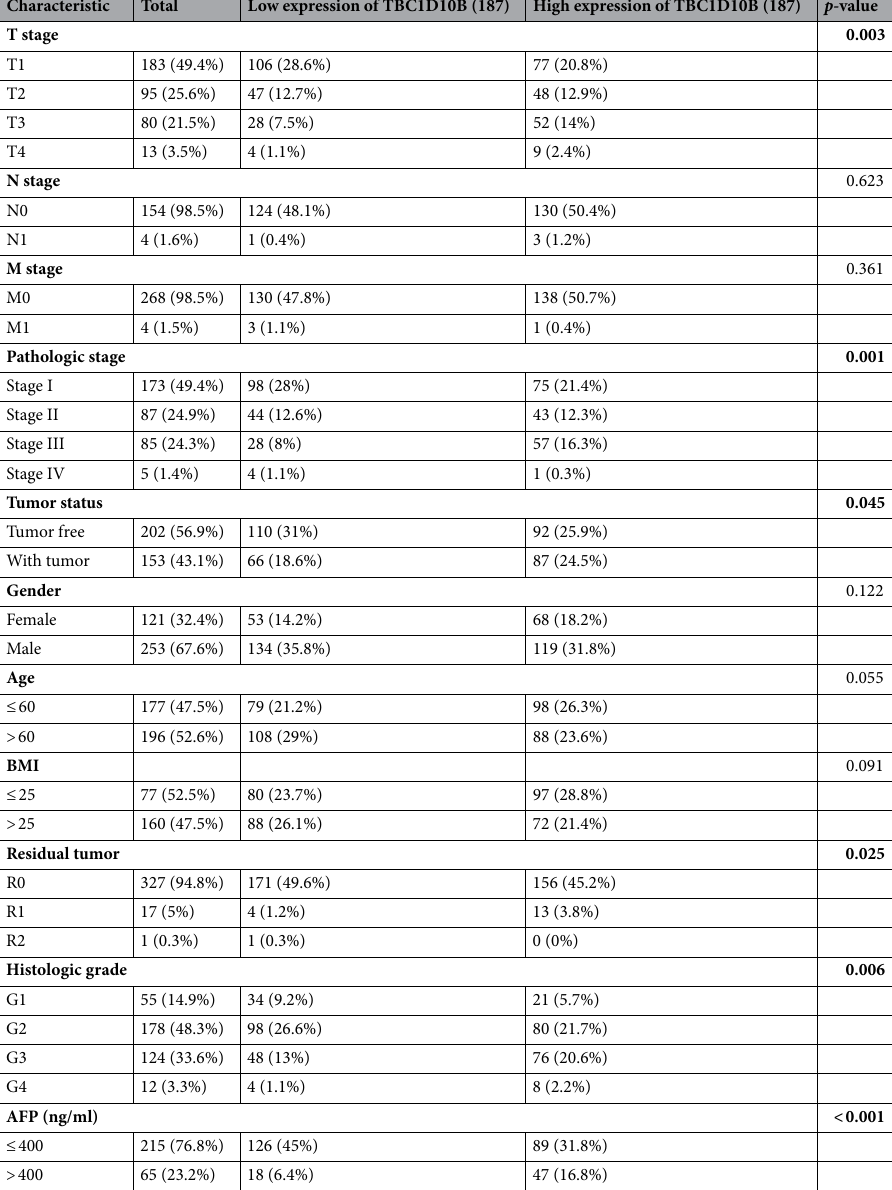
Table 2. Clinicopathological characteristics of LIHC patients with differential TBC1D10B expression. Significant values are in [bold]. LIHC liver hepatocellular carcinoma, AFP alpha-fetoprotein, BMI body mass